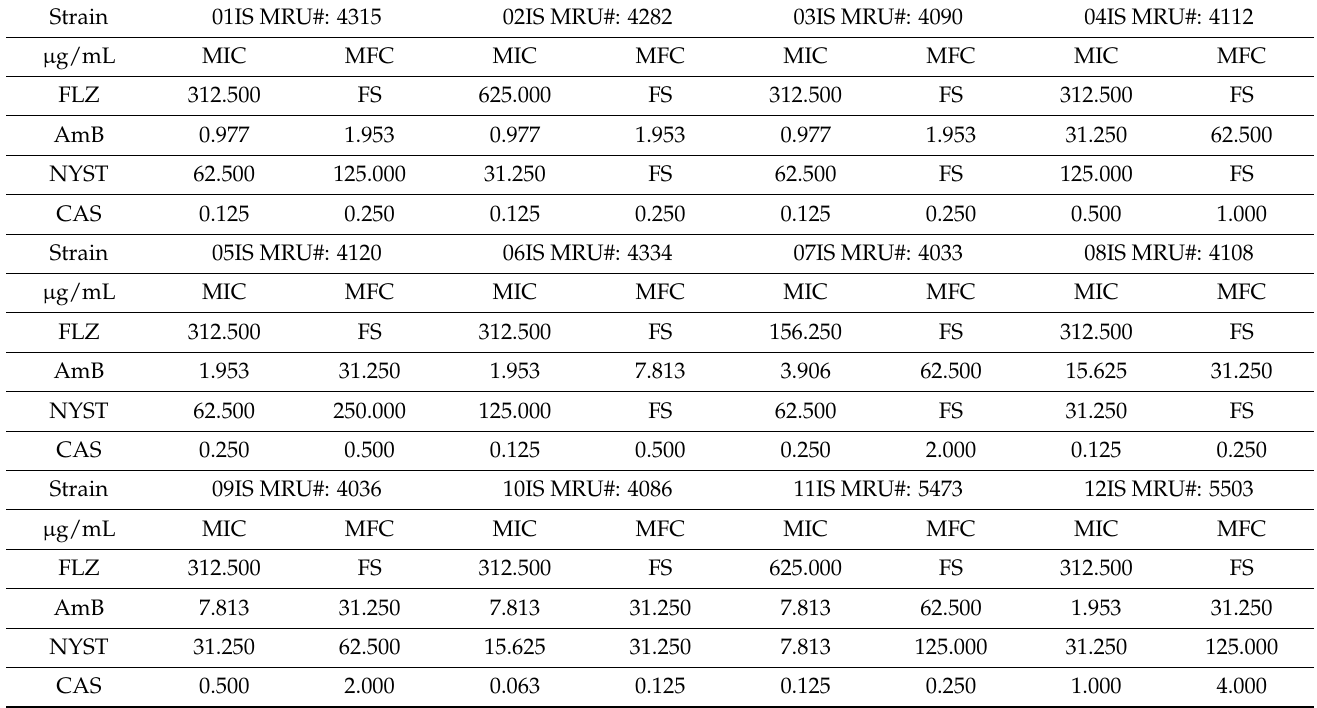
Table 1. Antifungal susceptibility